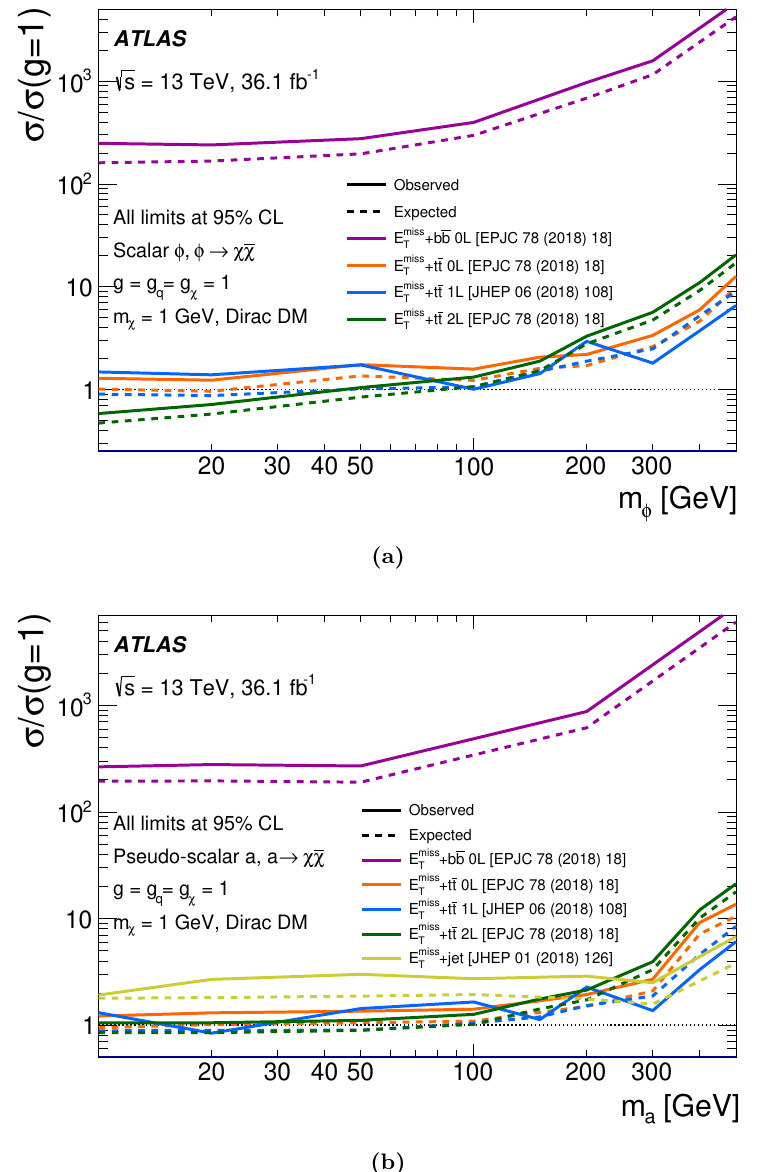
Figure 17. Exclusion limits for (a) colour-neutral scalar or (b) pseudo-scalar mediator models as a function of the mediator mass for a DM mass of 1 GeV. The limits are calculated at 95% CL and are expressed in terms of the ratio of the excluded cross-section to the nominal cross-section for a coupling assumption of g = g q = g (cid:31) = 1. The solid (dashed) lines show the observed (expected) exclusion limits for each channel.